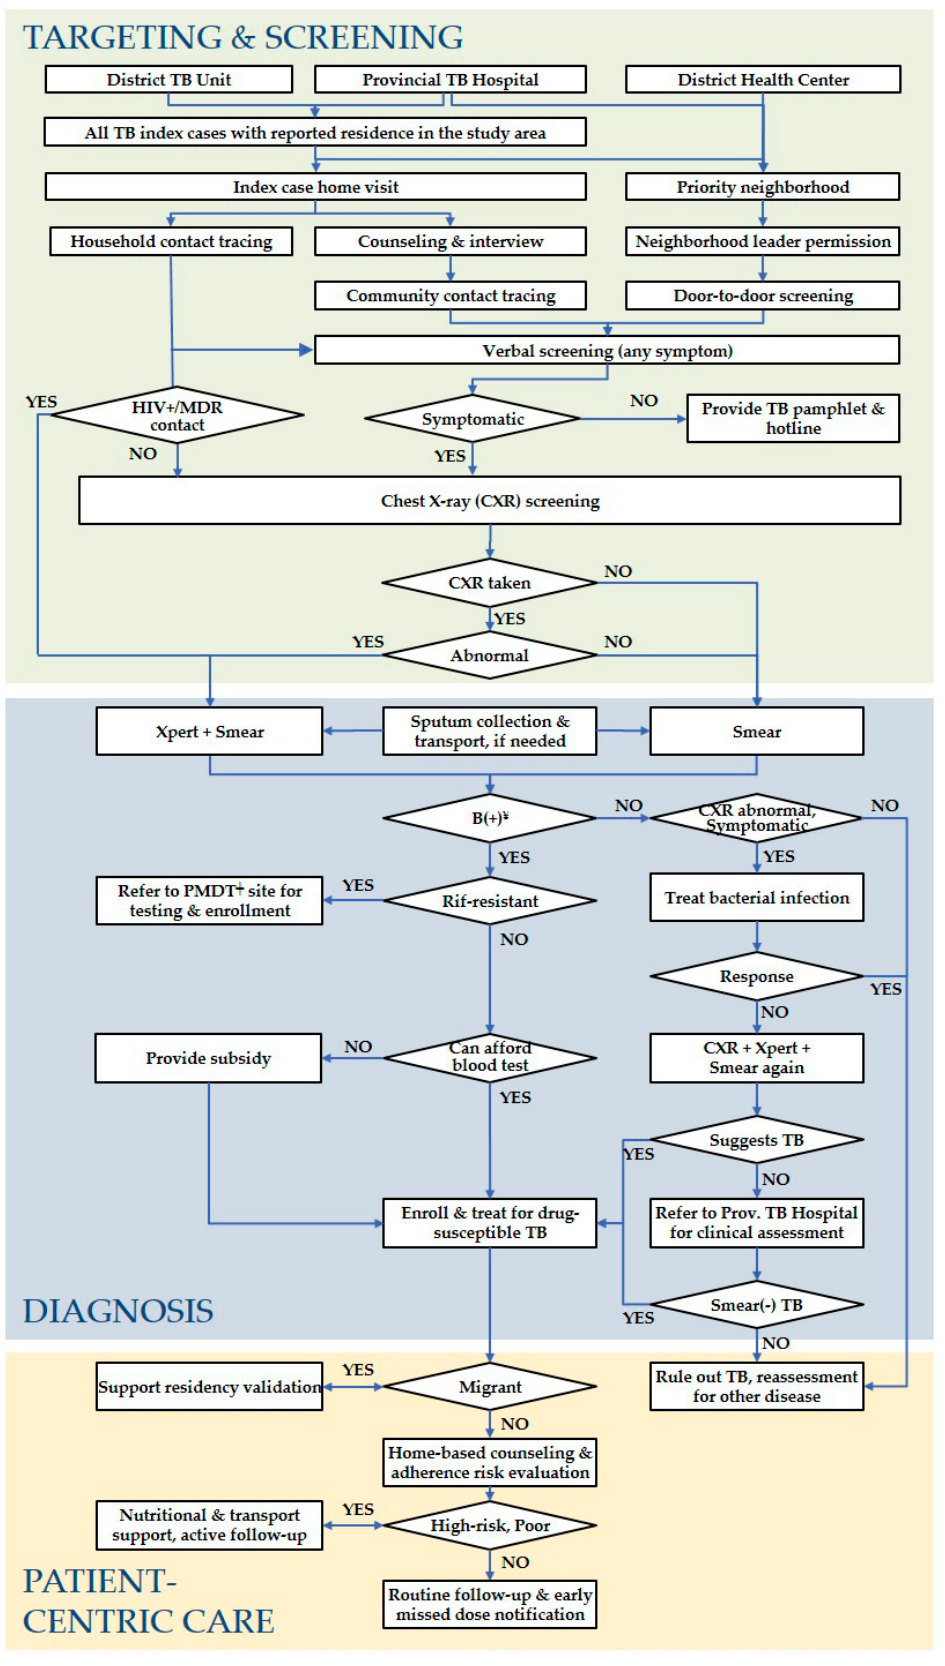
Figure 2. Process flow of the ACF activities. Hai Phong and Quang Nam, Viet Nam. January 2018 to March 2019. ¥ Bacteriologically-confirmed; ‡ Programmatic Management of Drug-Resistant